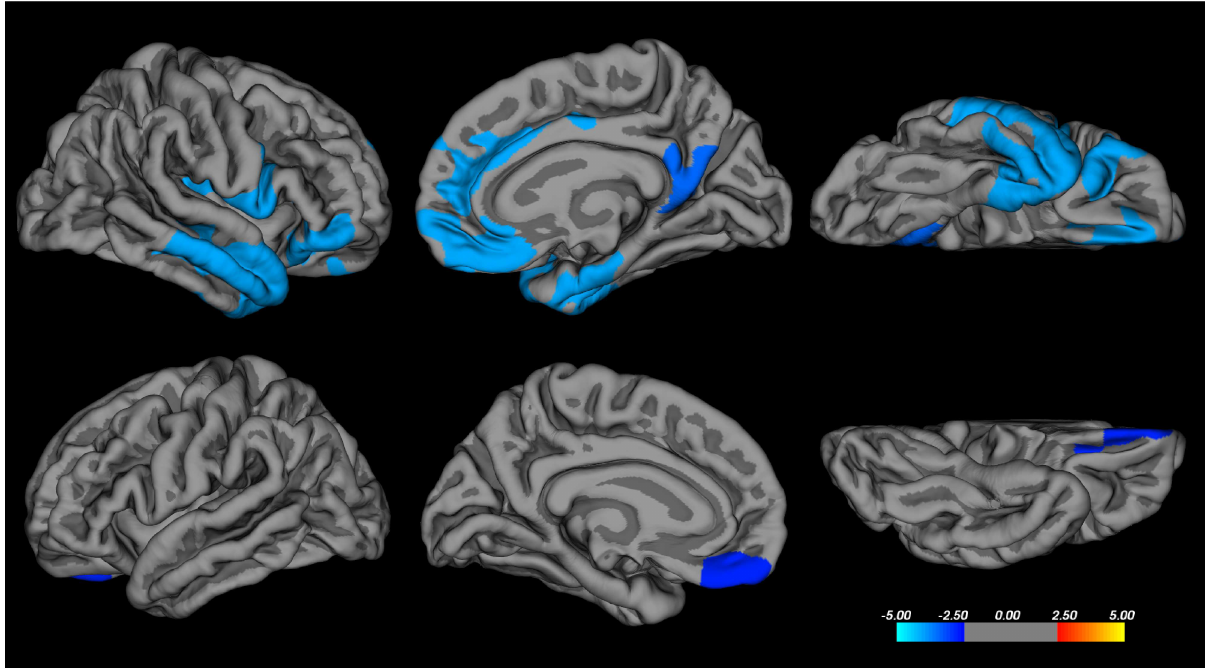
Fig 5. Cortical thinning in bvFTD patients. Results of the comparison of cortical thickness between patients with behavioural variant frontotemporal dementia and healthy controls. Results are from the Freesurfer analysis, results of the generallinear model analysiswere corrected for multiple comparisons at the cluster level using the Monte Carlo method for p-cluster at p < 0.01 (z-vertex 2.0). No nuisance variableswere entered into the model. Colouredareas represent areas of significant differences, where warmer colours represent cortical thickening and cooler colours cortical thinning. Scale bar represents p on a logarithmicscale. The upper row is the right hemisphere, the lower row is left hemisphere, from lateral, medial and inferior